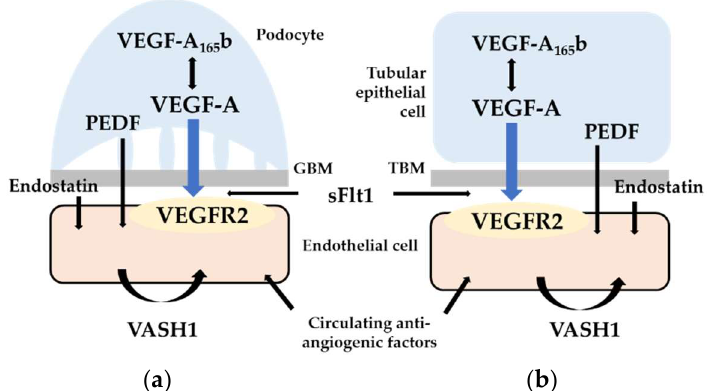
Figure 1. Endogenous antiangiogenic factors in ( a ) glomerulus (podocyte and glomerular endothelial cell) and ( b ) tubulointerstitium (tubular epithelial cell and peritubular capillary endothelial cell). See text for detailed physiological and pathological roles of each factor in kidney. Abbreviations: GBM, glomerular basement membrane; TBM, tubular basement membrane; VEGF-A, vascular